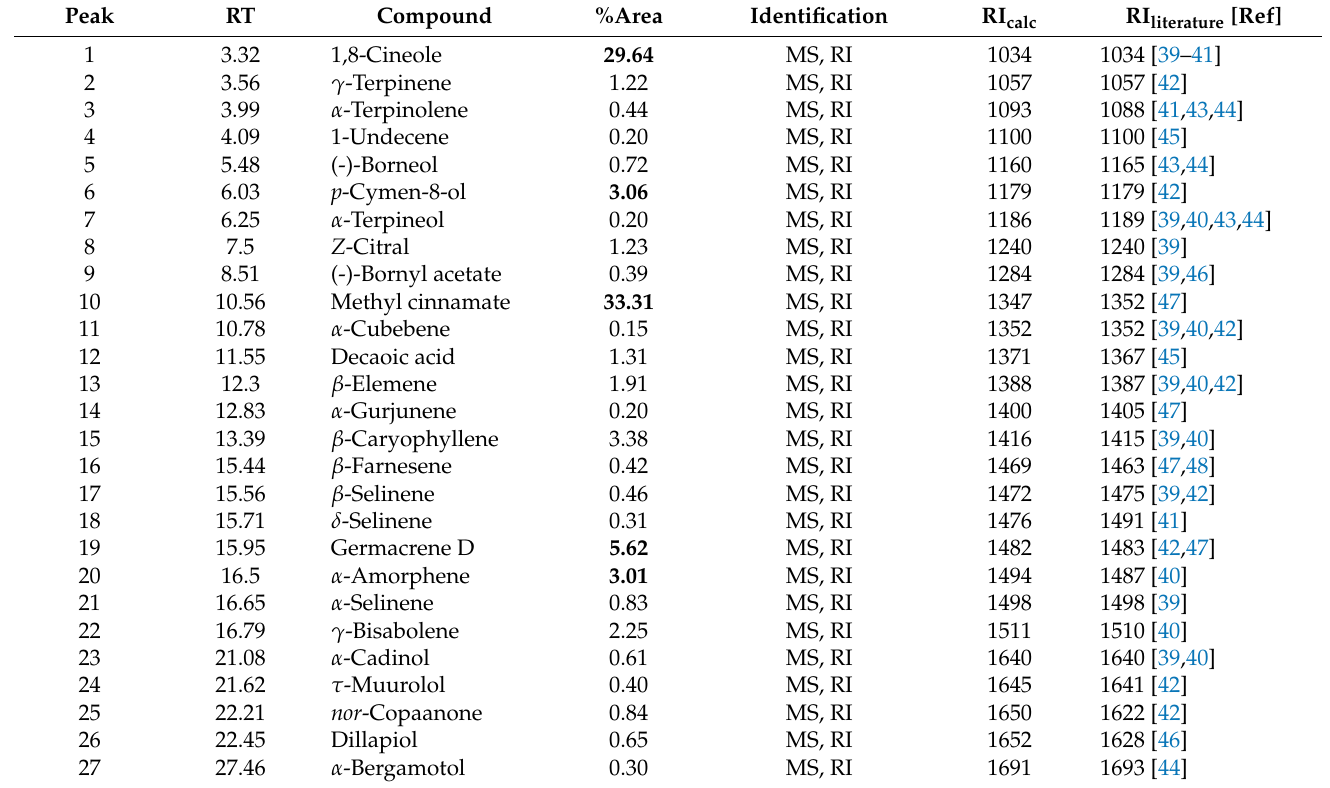
Table 1. Volatile constituents of A. galanga